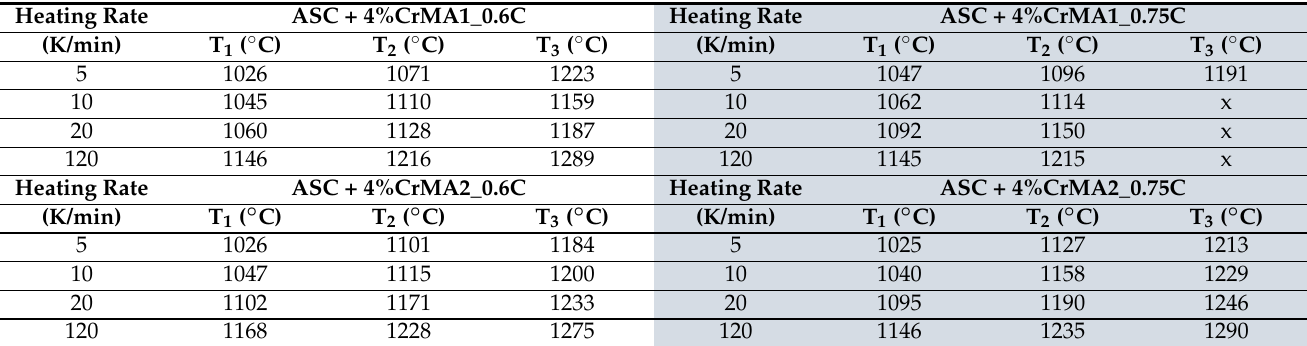
Table 3. Peak temperatures (T max ) for the different reactions and heating